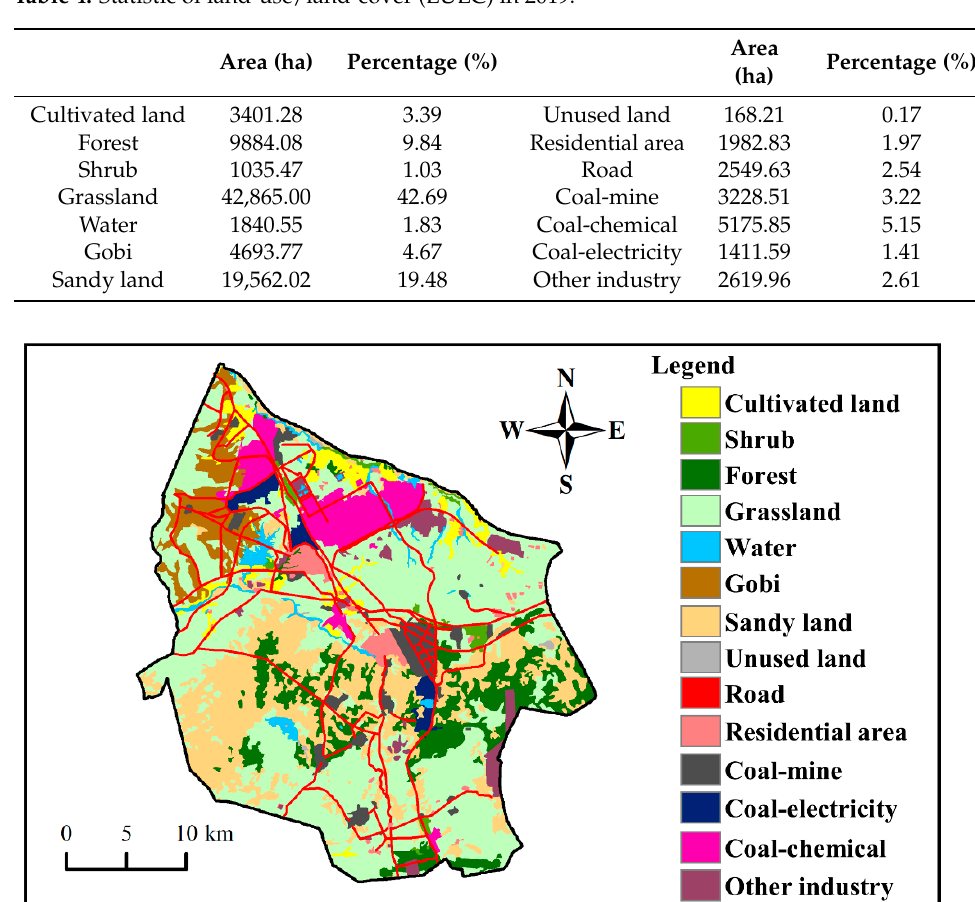
Figure 3. Land-use/land-cover (LULC) in 2019.